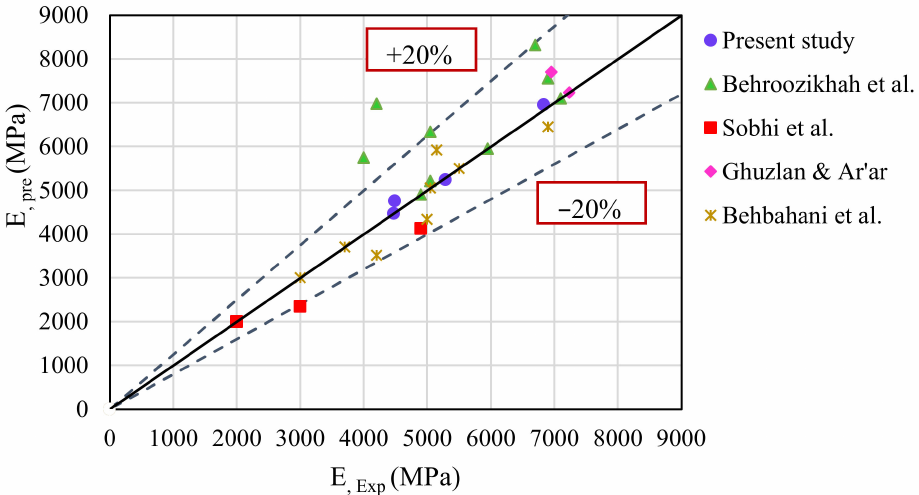
Figure 5. Comparison of the resilient modulus between the proposed model and the laboratory results of other